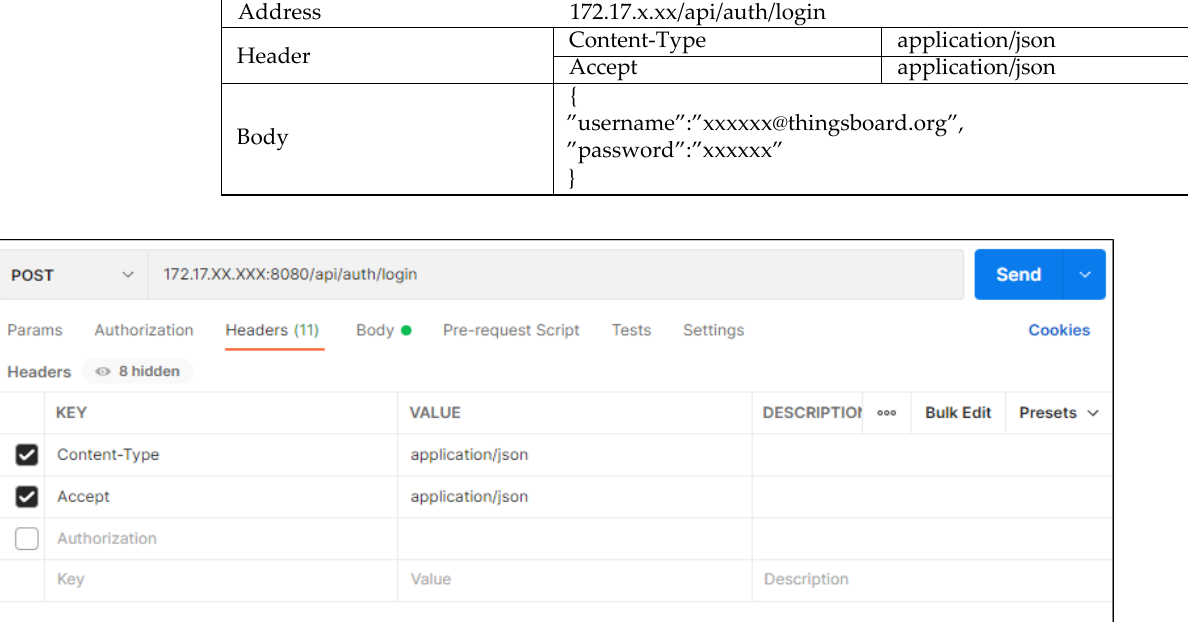
Figure 13. POSTMAN request for JWTtoken with the configuration above.